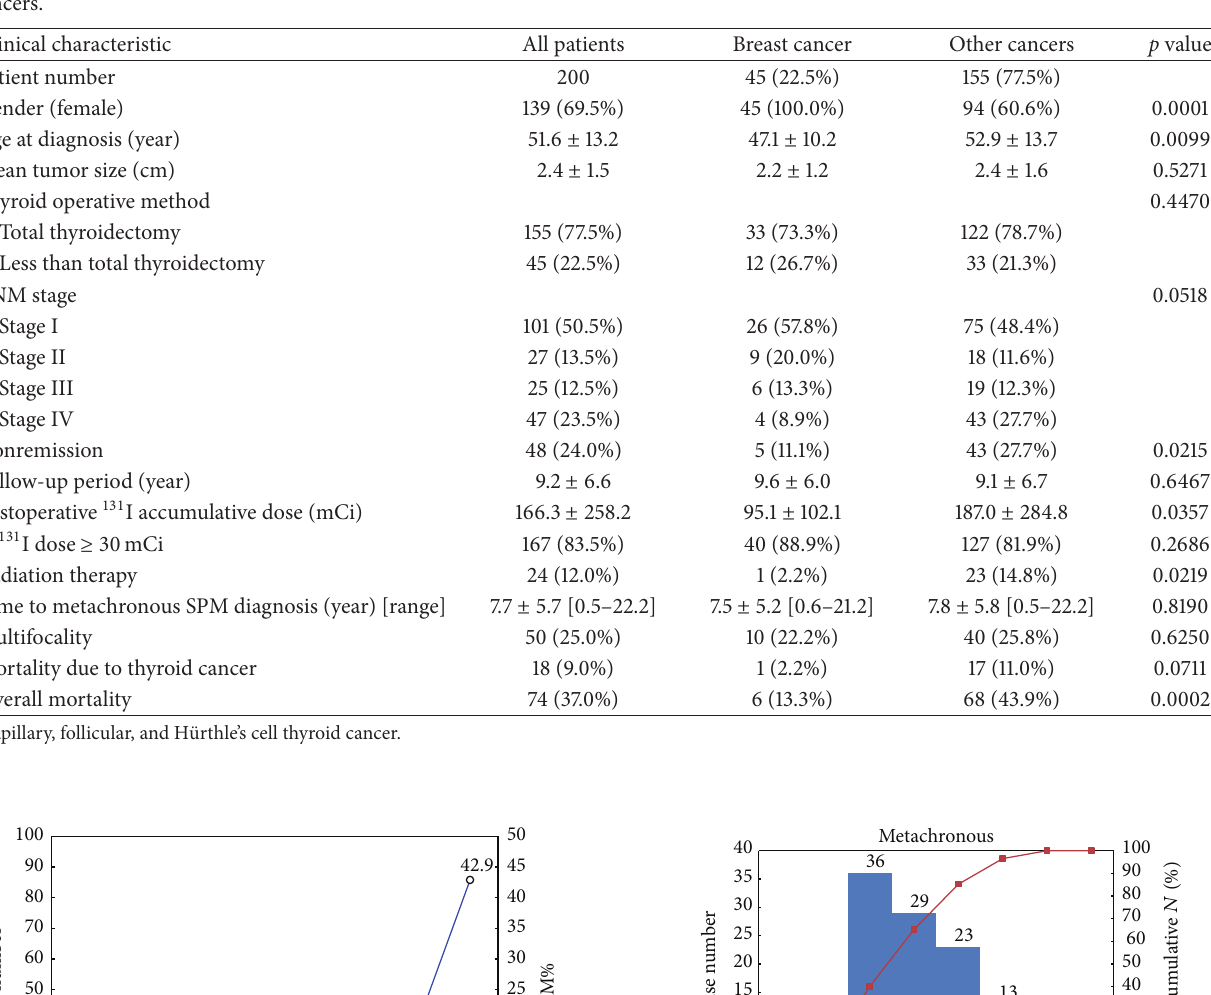
Table 3: Clinical features of 200 cases of well-differentiated thyroid cancer ∗ with second primary malignancy (SPM) as breast cancer or other cancers.